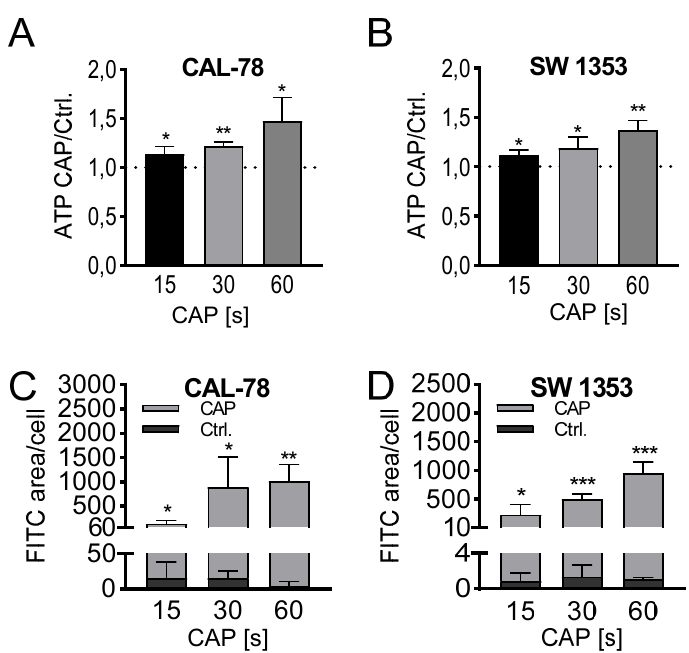
Figure 4. ATP release assay ( A , B ). CAL-78 ( A ) and SW1353 ( B ) cells were treated with 15, 30, or 60 s CAP or carrier gas argon. After an incubation period of 3 min, the relative ATP concentrations of the cell-free supernatants were measured using the CellTiter-Glo 2.0 reagent and fluorescence plate reader. The CAP treatment measurements were normalized to the control measurements. Dextran-uptake assay ( C , D ). CAL-78 ( C ) and SW1353 ( D ) cells were seeded on cover slides and incubated over 24 h. After incubation, cells were treated with 15, 30, and 60 s CAP or carrier gas argon. Cells were dyed with Fluorescein isothiocyanate (FITC) dextran and DAPI (4',6-Diamidino-2-Phenylindole, Dihydrochloride). Fluorescence of FITC and DAPI were recorded with a BZ-9000 microscope and analyzed with a BZ-II Analyzer (KEYENCE, Neu-Isenburg, Germany). The FITC-positive areas were measured and normalized to the count of DAPI-labeled cell cores. Data are given as mean ± SD; significant differences are indicated as follows: * p ≤ 0.05, ** p ≤ 0.01, *** p ≤ 0.001.